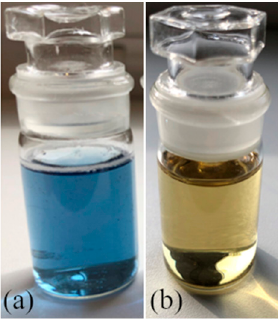
Figure 1. Colloidal solution: sample B ( a ) and I ( b ).